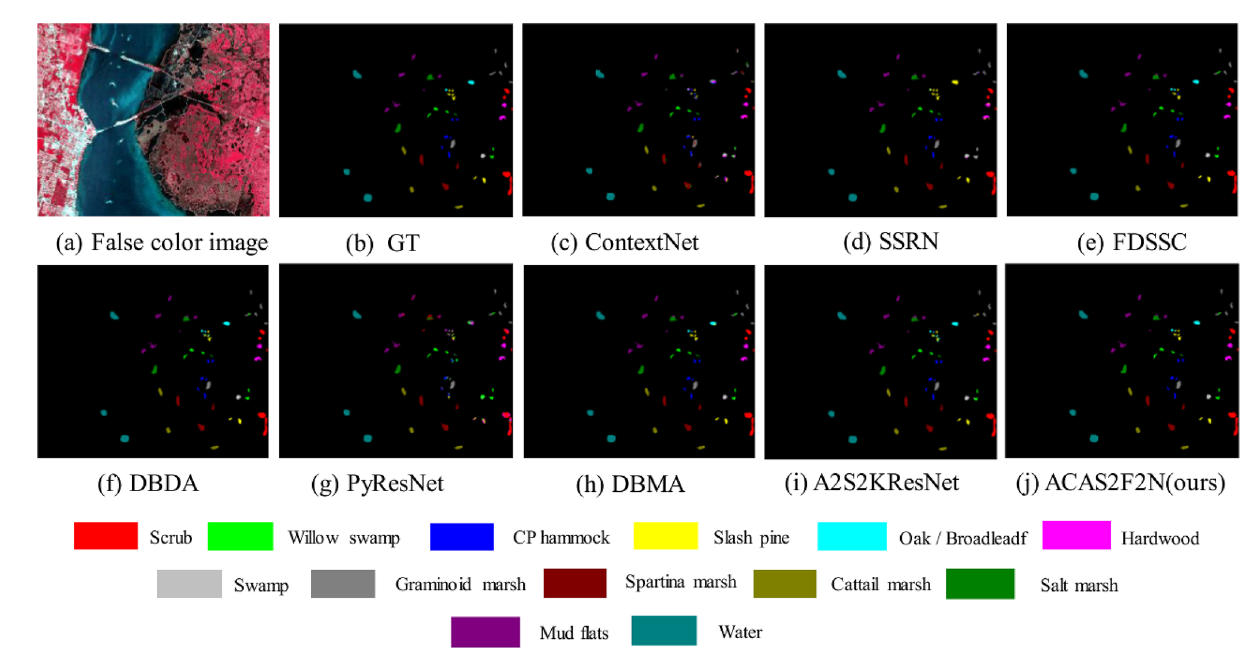
Figure 6. Hyperspectral classification maps on KSC. ( a ) False color image. ( b ) Ground truth. ( c – i ) Performance of all baselines. ( j ) Performance of the proposed ACAS2F2N. The other content is color and label